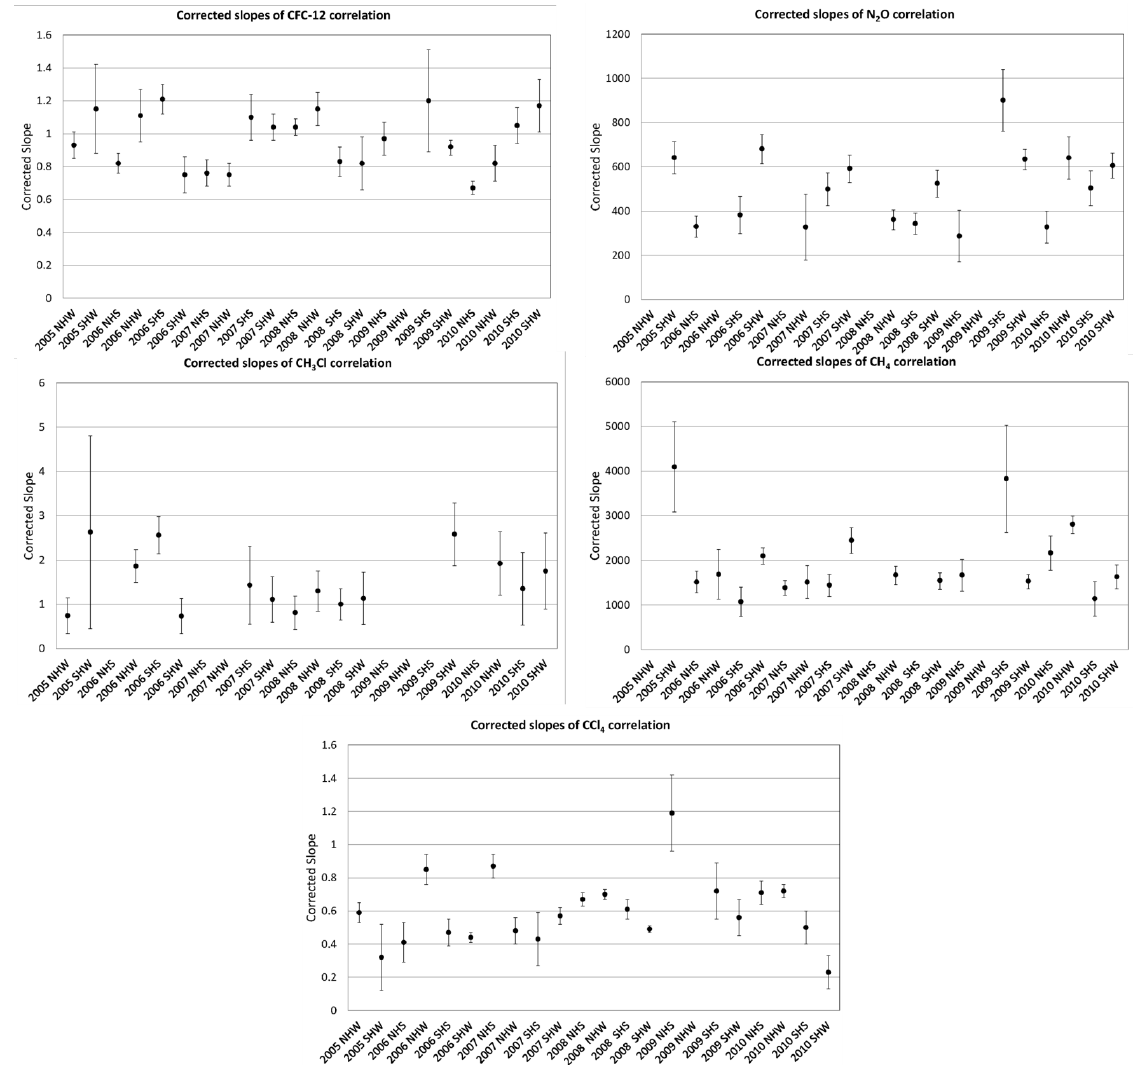
Figure A2 A graphical representation of the corrected slopes of the various correlations with CFC-11. The data is presented in the same order as it appears in Table